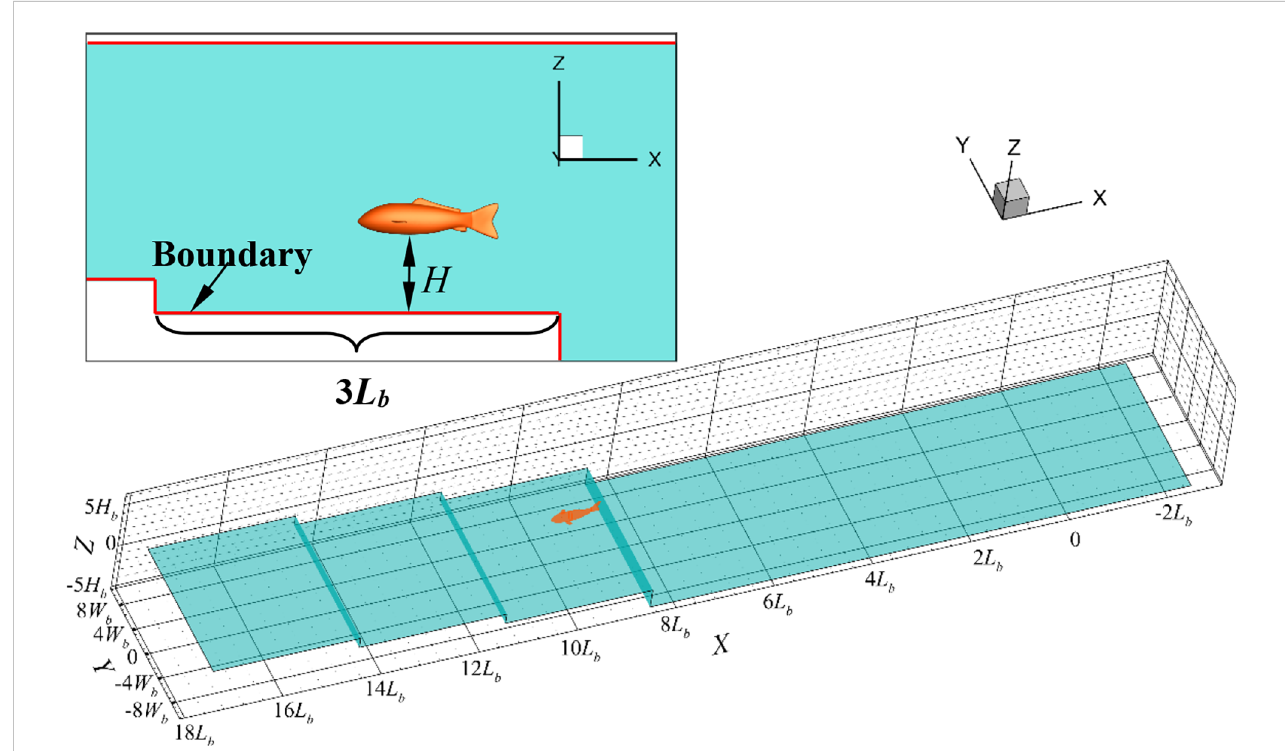
FIGURE 3 The undulating seabed boundary model.